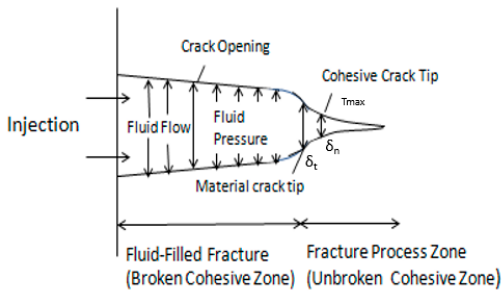
Figure 3. The hydraulic fracture tips.